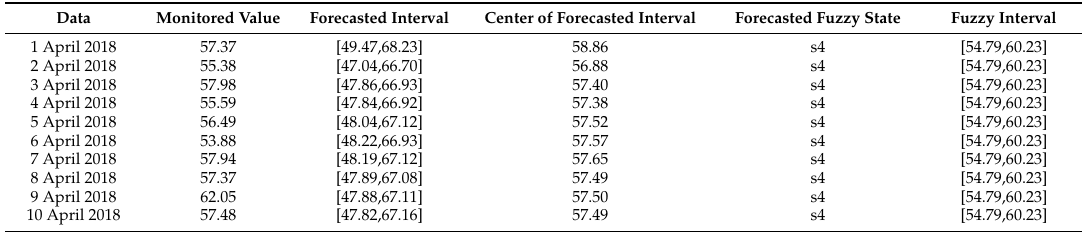
Table 7. Validity of proposed mode for h = 1, 2, . . . ,